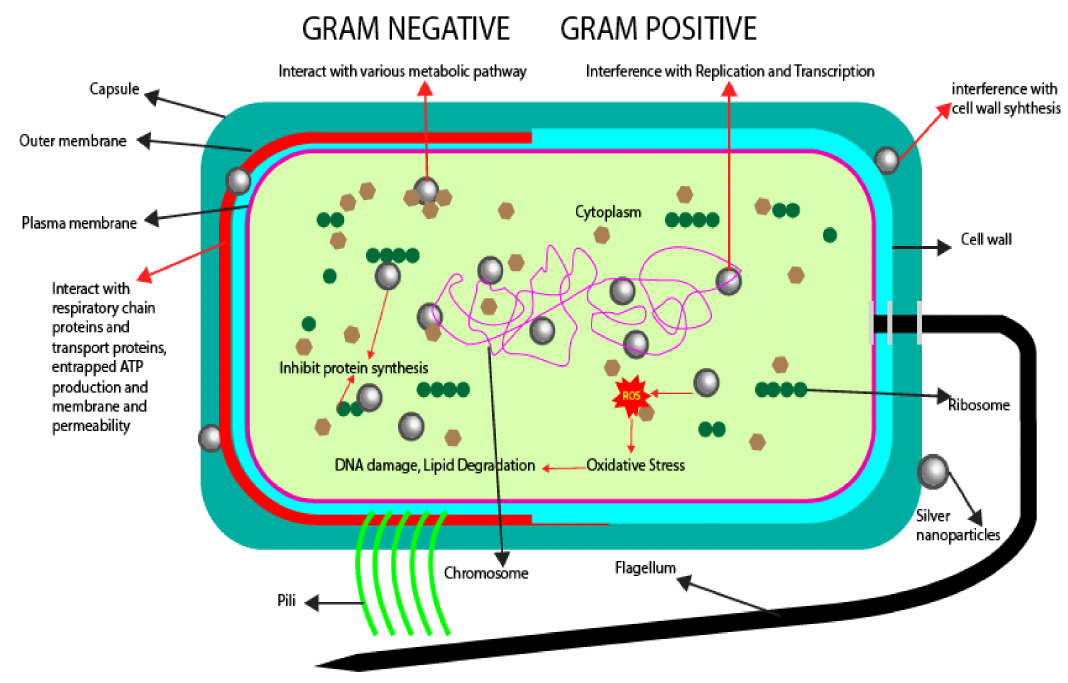
Figure 9. Possible mechanism of silver nanoparticles towards